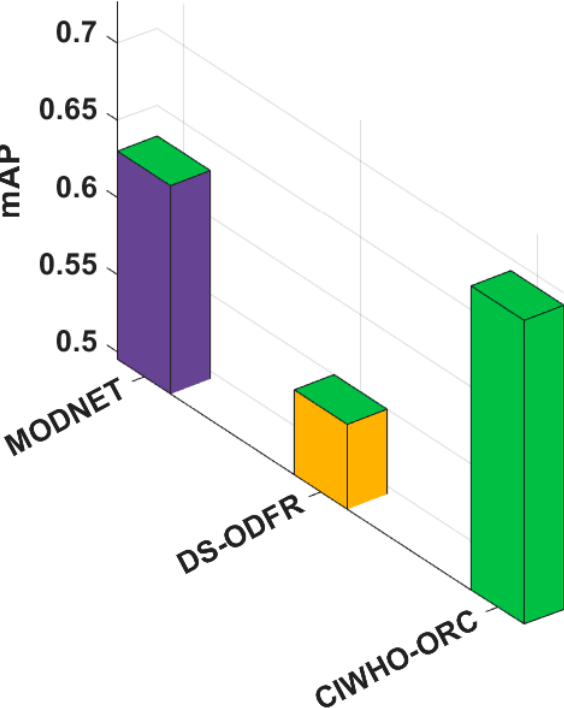
Figure 7. Comparative Classifier Results of CIWHO-ORC technique on KITTI MOD dataset.